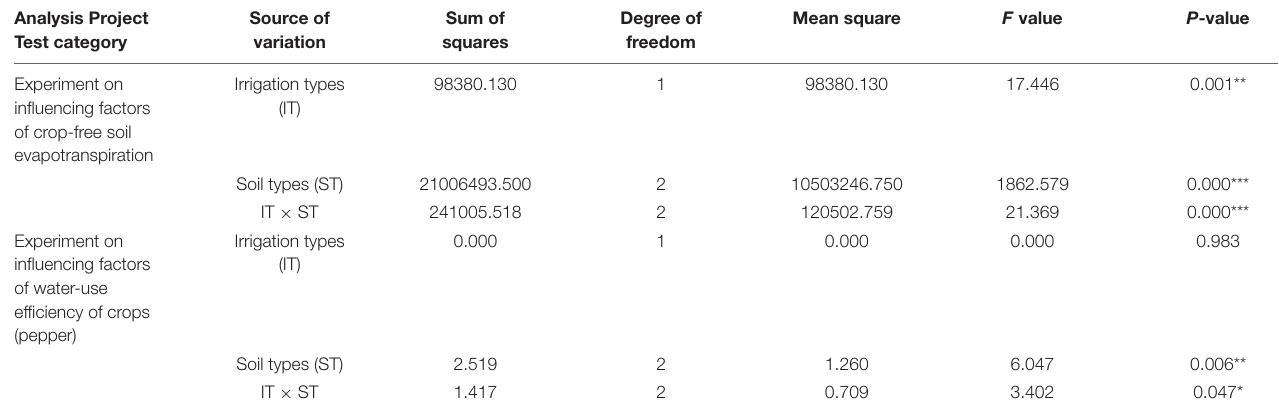
TABLE 3 | Variance analysis